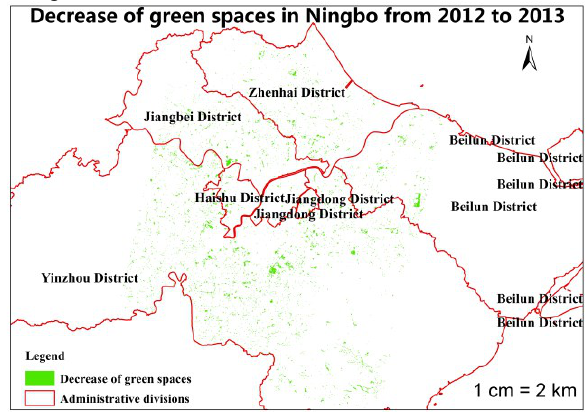
Figure 2. Decrease of green space in Ningbo from 2012 to 2013